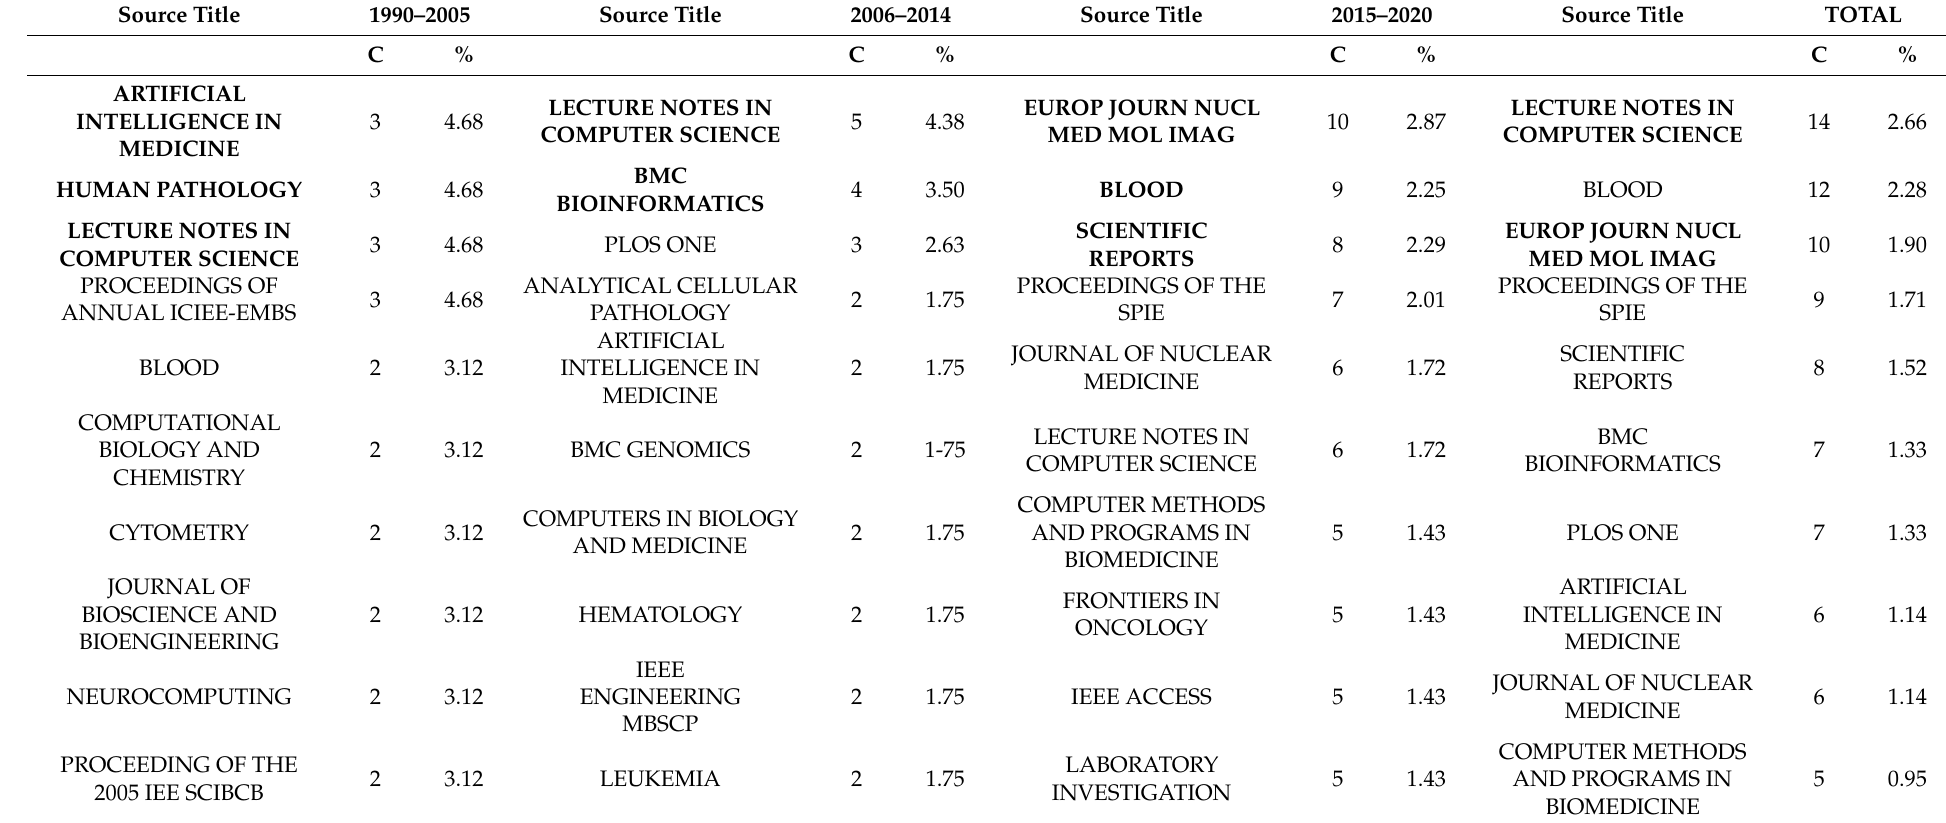
Table 2. Analysis of documents referred to AI and ML applications to diagnostic pathology in lymphoid neoplasms by source titles from 1990 to 2020. Data are provided for three subperiods (1990–2005; 2006–2014; 2015–2020) and globally. Bold type indicates Bradford nuclei for the 25% of total production for each period. Source titles are abbreviated. C: document count; %: percentage of